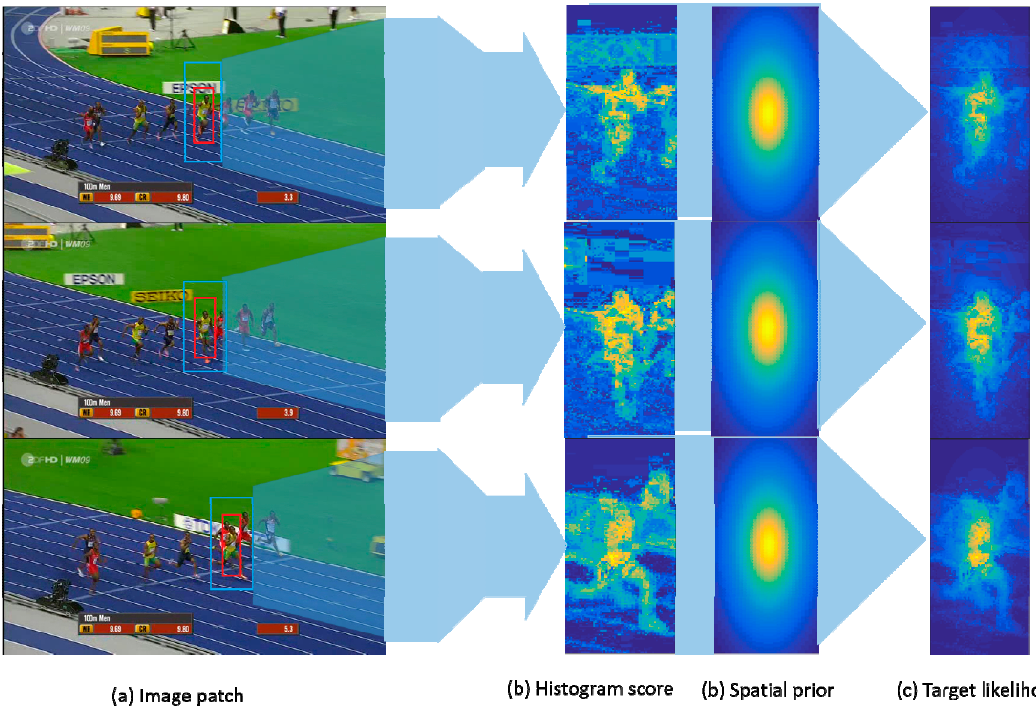
Figure 6. Column ( a ) displays the screenshots from Bolt at frames 75, 90 and 125. The target and search area are respectively specified by the red and blue bounding boxes. The effects of enhancements with histogram scores are visualized as column ( b ). The final weights assigned to features are shown are column ( c ).